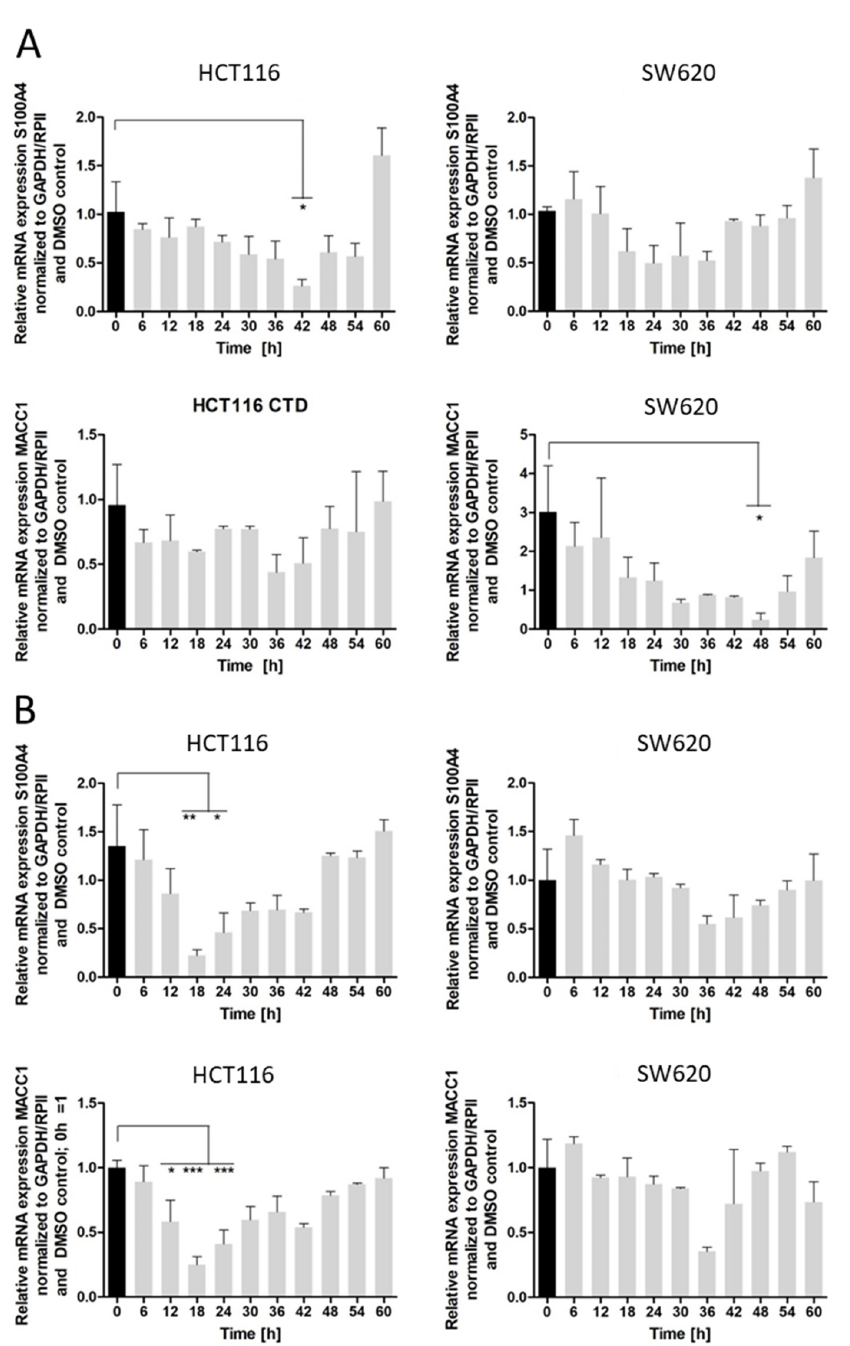
mean ± SEM ( n = 3), * p < 0.05, ** p < 0.01, *** p < 0.001. Protein levels were analyzed by immunoblot assay with β -actin as a loading control. The blots represent one of the three independent experiments. ( A ) Effect of cantharidin on MACC1 mRNA and protein expression in HCT116 and SW620 cells. Top : 24 h treatment and bottom : 48 h treatment. HCT116 cells on the left side and SW620 cells on the right side. ( B ) Effect of norcantharidin on MACC1 mRNA and protein expression in HCT116 and SW620 cells. Top : 24 h treatment and bottom : 48 h treatment. HCT116 cells on the left side and SW620 cells on the right side.